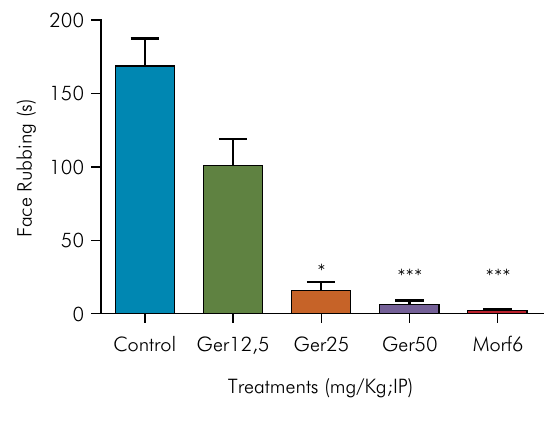
Figure 4. Effect of geraniol on formalin-induced nociception. Control (0.2% Tween 80); geraniol (12.5, 25 and 50 mg/kg IP); morphine (6 mg/kg IP). Values are expressed as the mean ± SD (n = 7 in each group); p* = 0.01; p**= 0.0008 versus control (one-way ANOVA followed by the t-test for heterogeneous